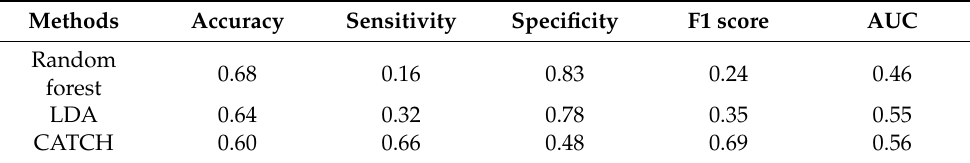
Table 1. Performance of machine learning models.